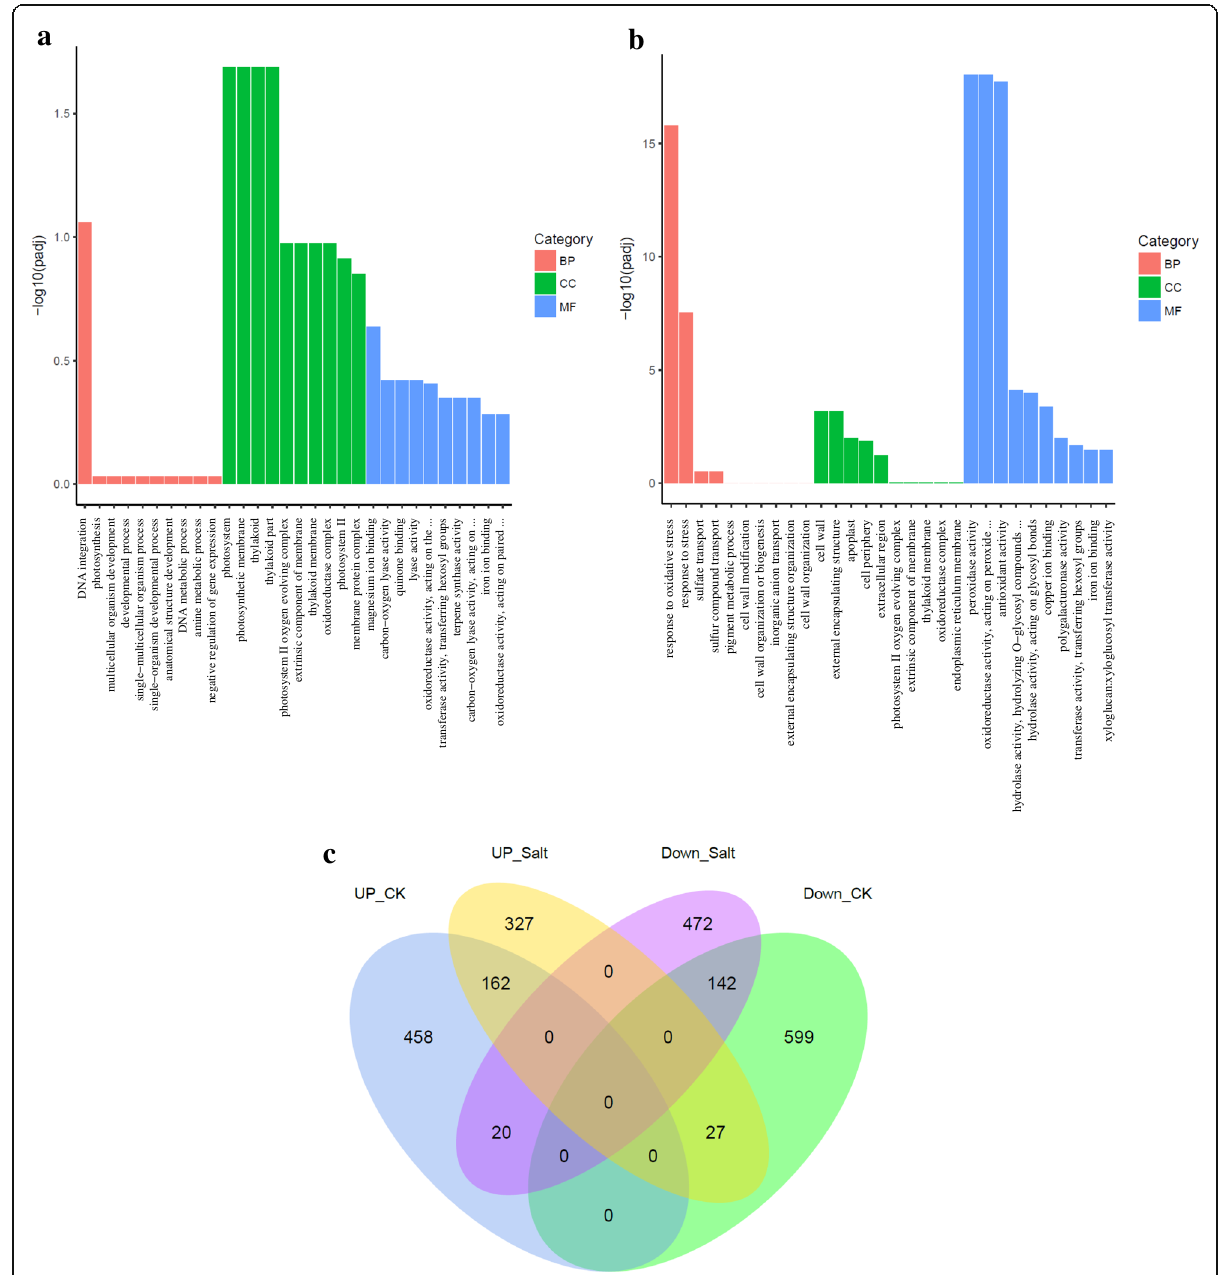
Fig. 7 Transcriptome analysis of OsNAC45 -regulated genes. Classification of up-regulated genes ( a ) and down-regulated genes ( b ) in osnac45 (MT) transgenic plants compared with the WT under normal conditions. c Venn diagram of the numbers of genes that are regulated by OsNAC45 in the MT and WT lines. UP_CK: the up-regulated genes in the MT compared with the WT under normal conditions (fold-change > 2). UP_SALT: the up-regulated genes in the MT compared with the WT in high salinity (fold-change > 2). DOWN_SALT: the down-regulated genes in the MT